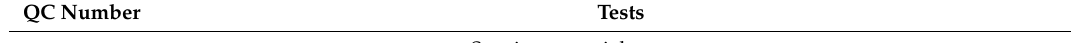
Starting material